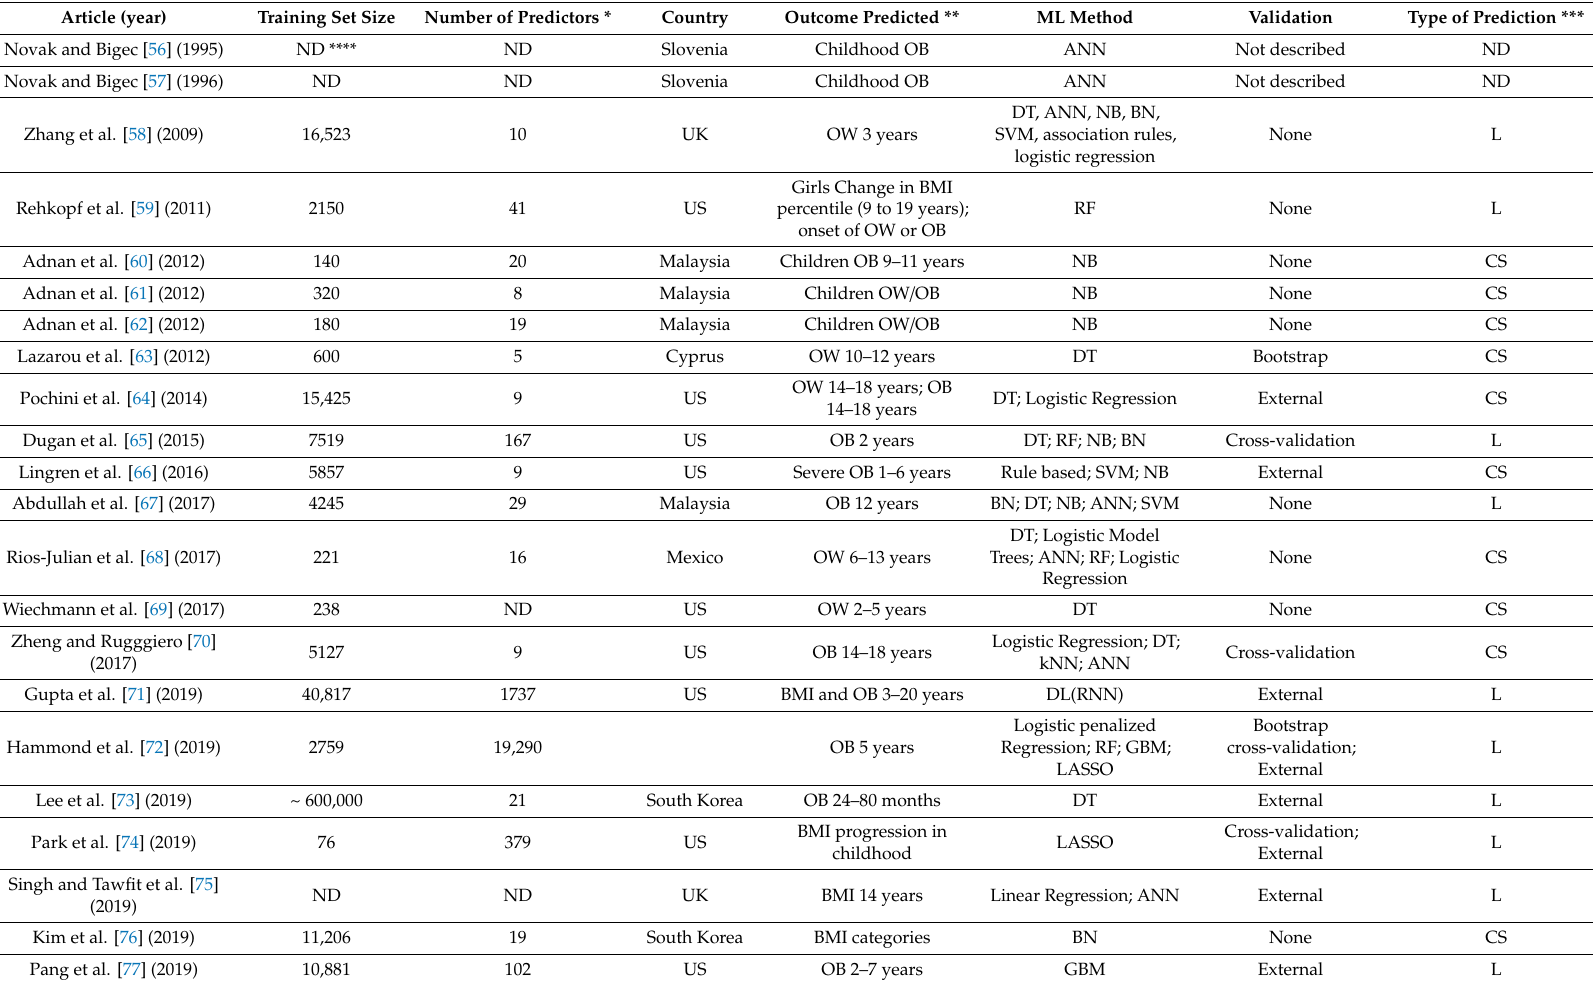
Table 2. Machine Learning (ML) models to predict BMI or its